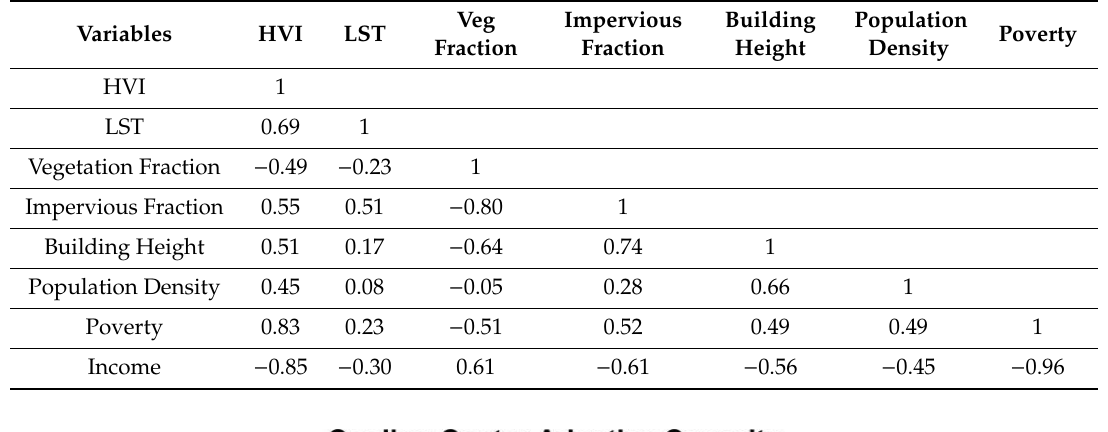
Table A2. Correlation coe ffi cients of selected variables used in the HVI analysis.